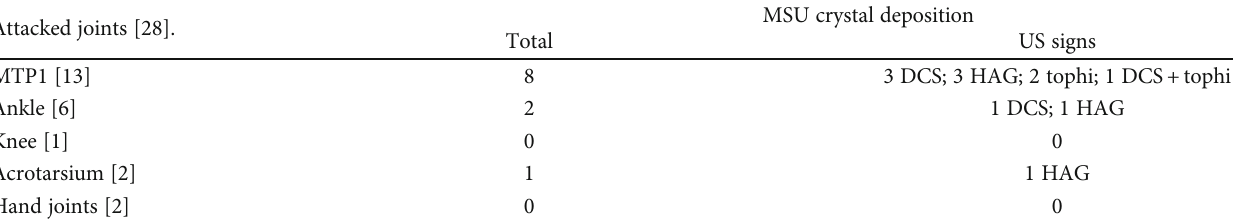
(b) US assessment in patients at fi rst acute attack